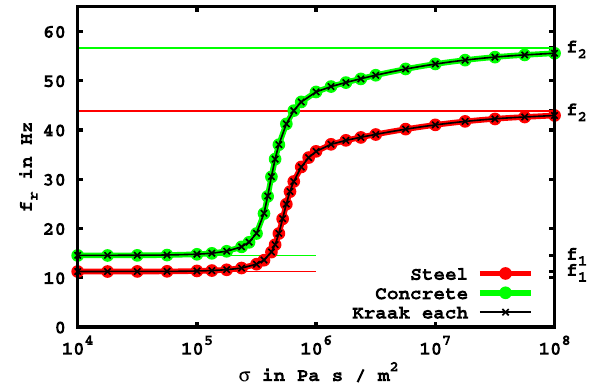
Figure 15. Shift of the resonance frequency f r depending on the fl ow resistivity r for steel and concrete plates, lines for asymptotes at f 1 and f 2